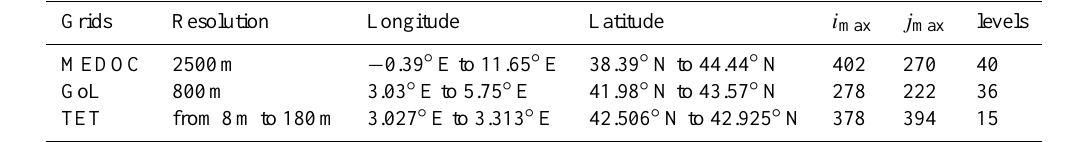
Table 3. Computational grids used in the circulation model. i max and j max are respectively the numbers of points in the west–east and south–north directions.